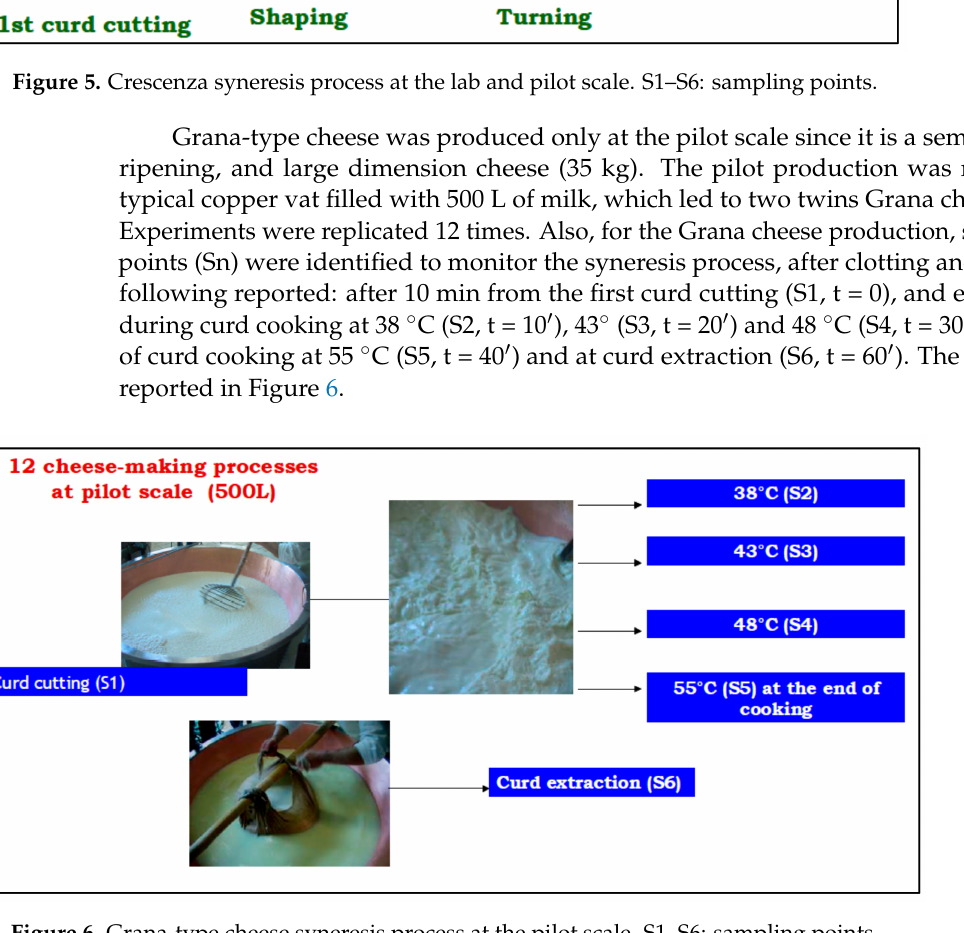
Figure 6. Grana-type cheese syneresis process at the pilot scale. S1–S6: sampling